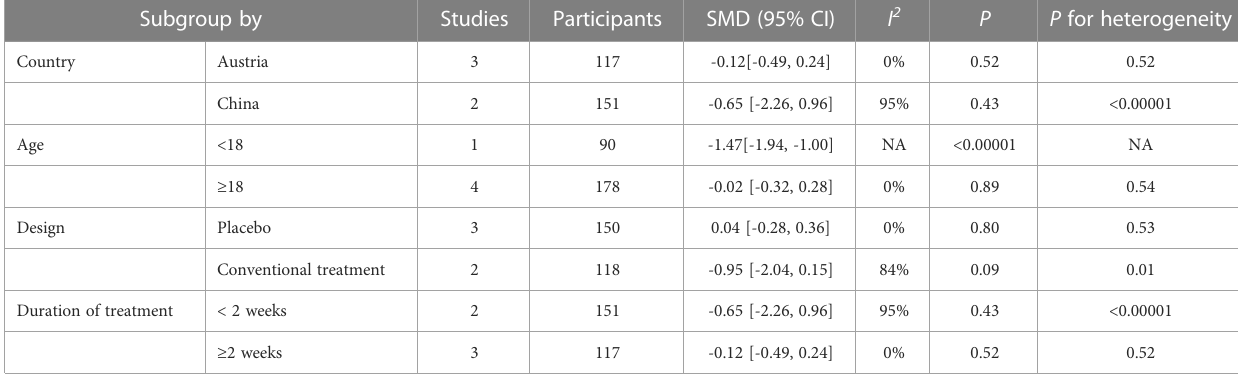
TABLE 6 Subgroup analysis of